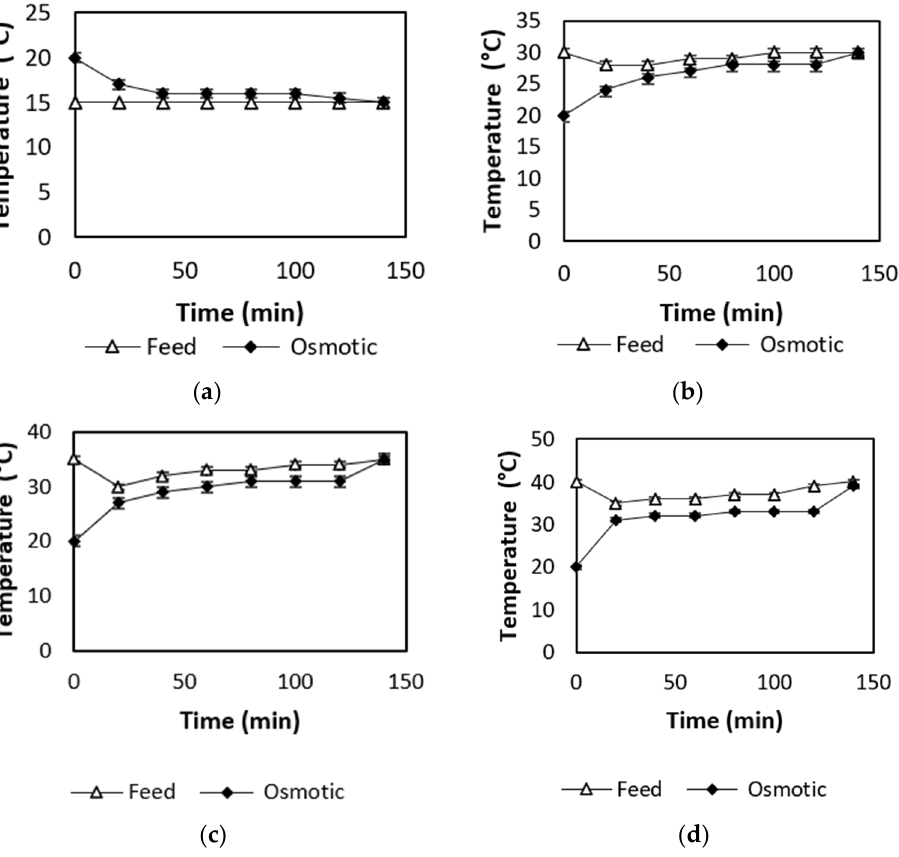
Figure A1. Feed and osmotic temperature evolution with time during the thermal evaluation of membrane distillation crystallization: ( a ) 15 °C; ( b ) 20 °C; ( c ) 35 °C; ( d ) 40 °C.